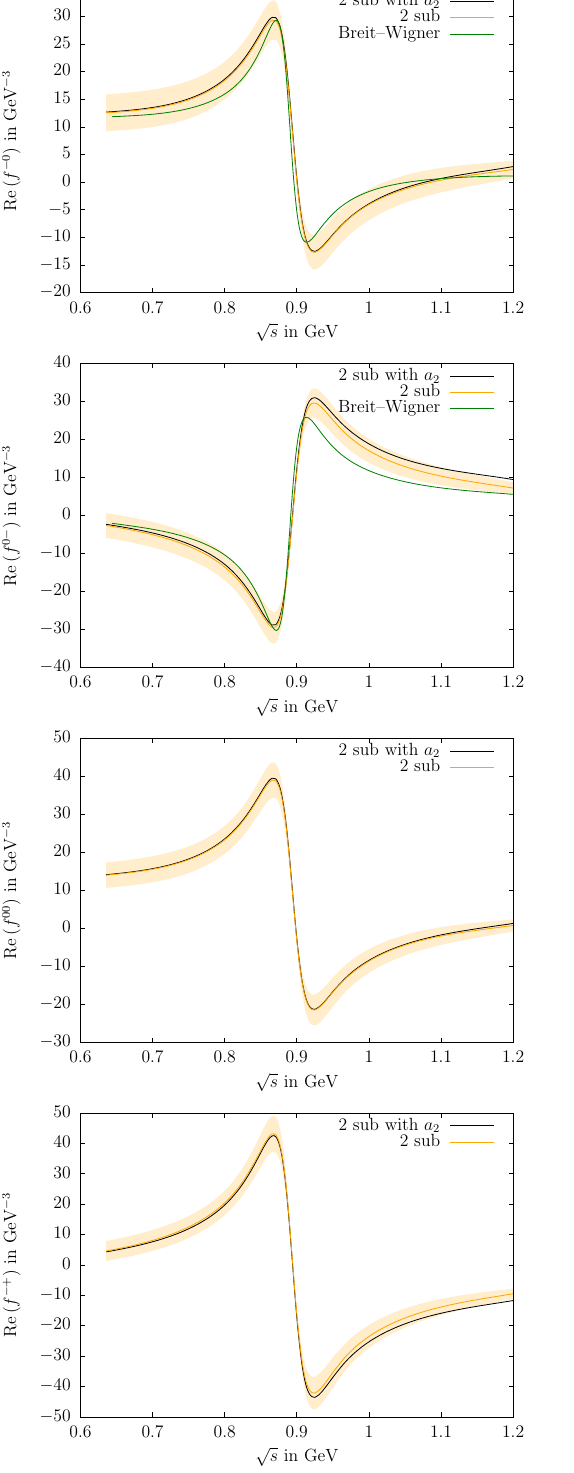
Fig. 7 Results for γ K − → K − π 0 , γ K − → ¯ K 0 π − , γ ¯ K 0 → ¯ K 0 π 0 , and γ ¯ K 0 → K − π + P -wave amplitudes (from top to bottom), matched to the anomaly and the couplings simultaneously in the twice subtracted scheme, with and without the a 2 resonance. Left and right panels show